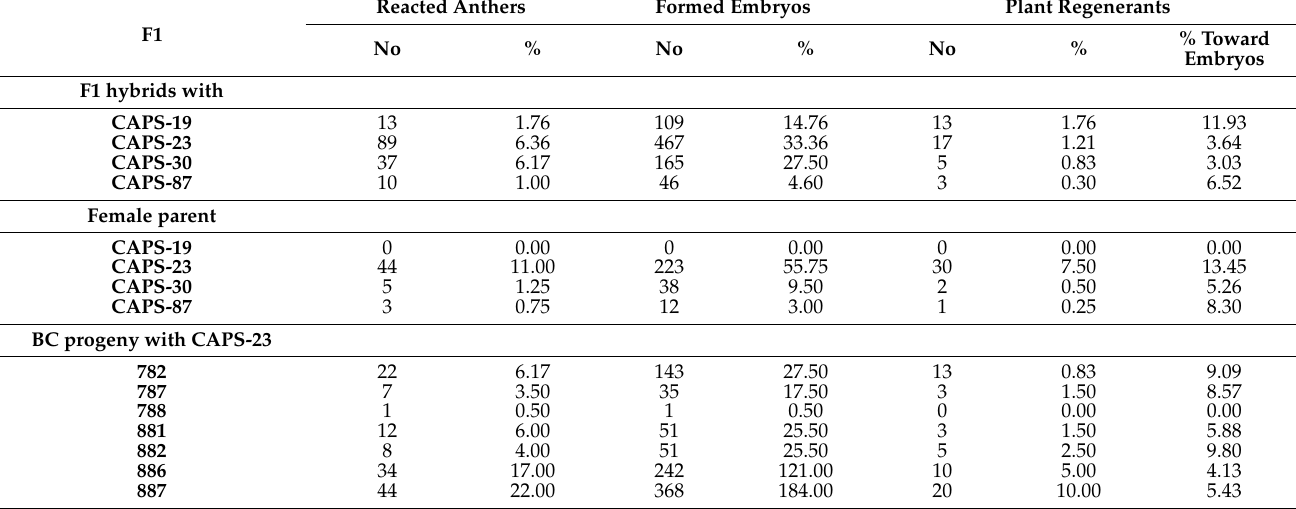
Table 2. Androgenic response observed in pepper F1 hybrids and their respective